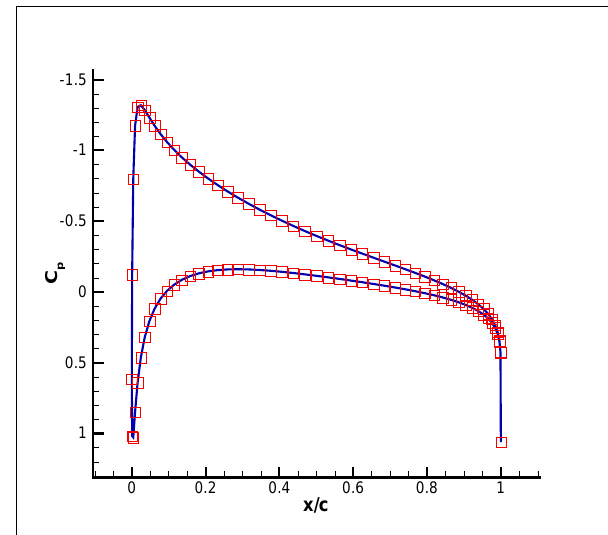
Figure 12. The pressure coefficient distribution for NACA0012 using FOILcom ( M ∞ = 0.5, α = 3 ◦ ).